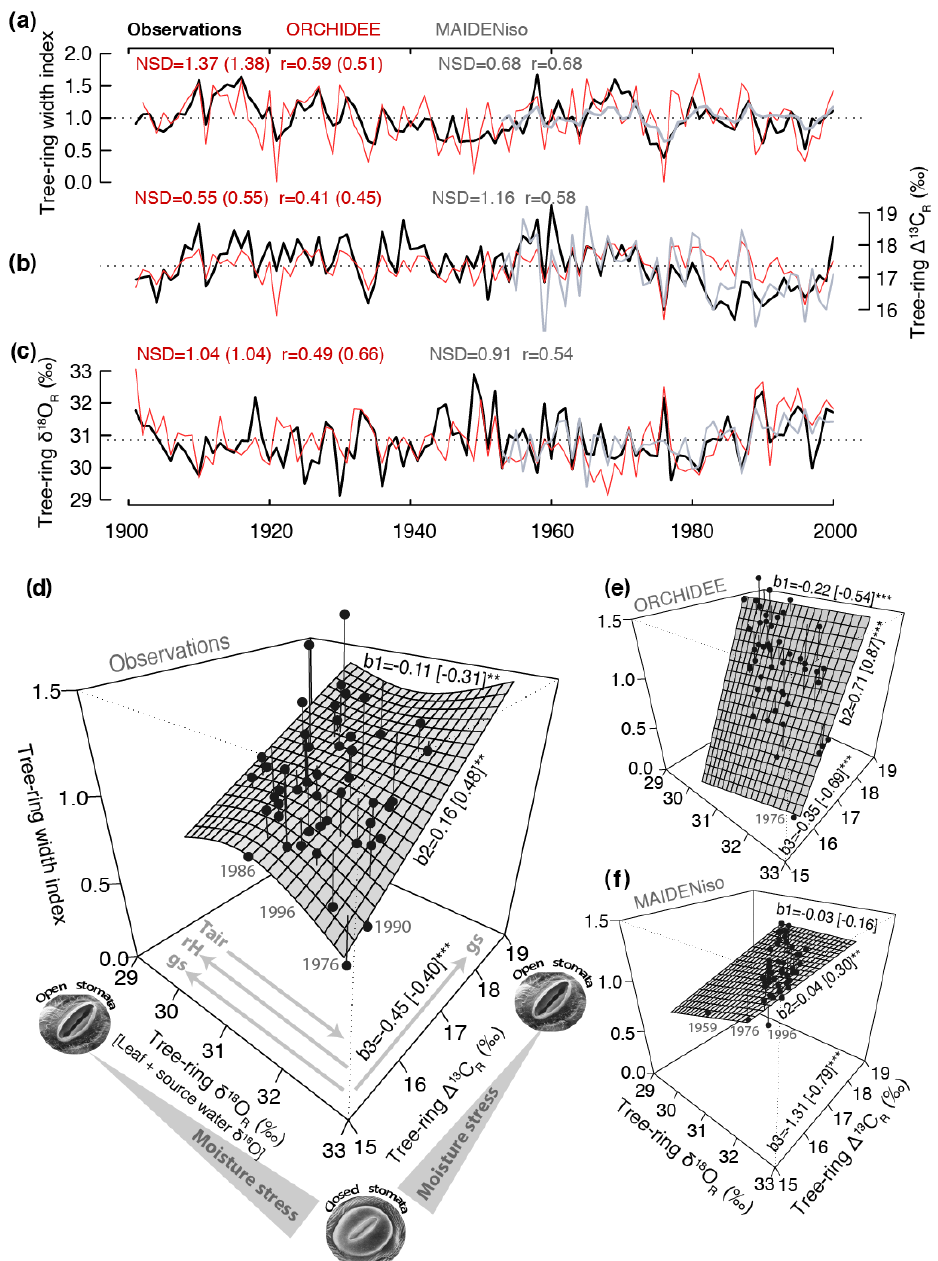
Figure 1. Comparison of simulated and observed tree-ring width and isotopic variability in Fontainebleau and the triple tree-ring constraint to assess the integrated model responses. (a–c) Comparison of tree-ring width and latewood (cid:49) 13 C R and δ 18 O R variability simulated by ORCHIDEE (red) and MAIDENiso (gray) with observations (black). The normalized standard deviation (NSD) and Pearson correlation ( r ) are indicated in each case. The mean of the simulations was set to that of the observations for each parameter. (d–f) Bivariate response surface of tree-ring width as a function of δ 18 O R and (cid:49) 13 C R variability based on observations and on ORCHIDEE and MAIDENiso simulations over the common period 1953–2000. The individual years are indicated by the black dots, and their vertical distance to the surface is represented by the lines. The most extreme years with low growth and high moisture stress are labeled in each panel. The regression slopes between the tree-ring variables are indicated along the edges of each surface: tree-ring width vs. δ 18 O R ( b 1), tree-ring width vs. (cid:49) 13 C R ( b 2), and (cid:49) 13 C R vs. δ 18 O R ( b 3) as predictand vs. predictor order. In each case, the linear correlation is indicated in brackets. The asterisks denote